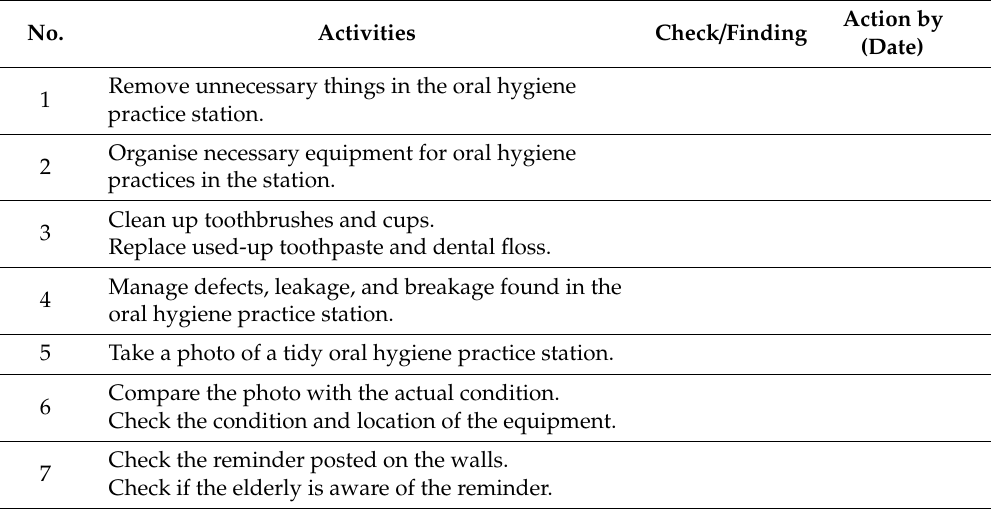
Table 1. 5S checklist of sustained oral hygiene